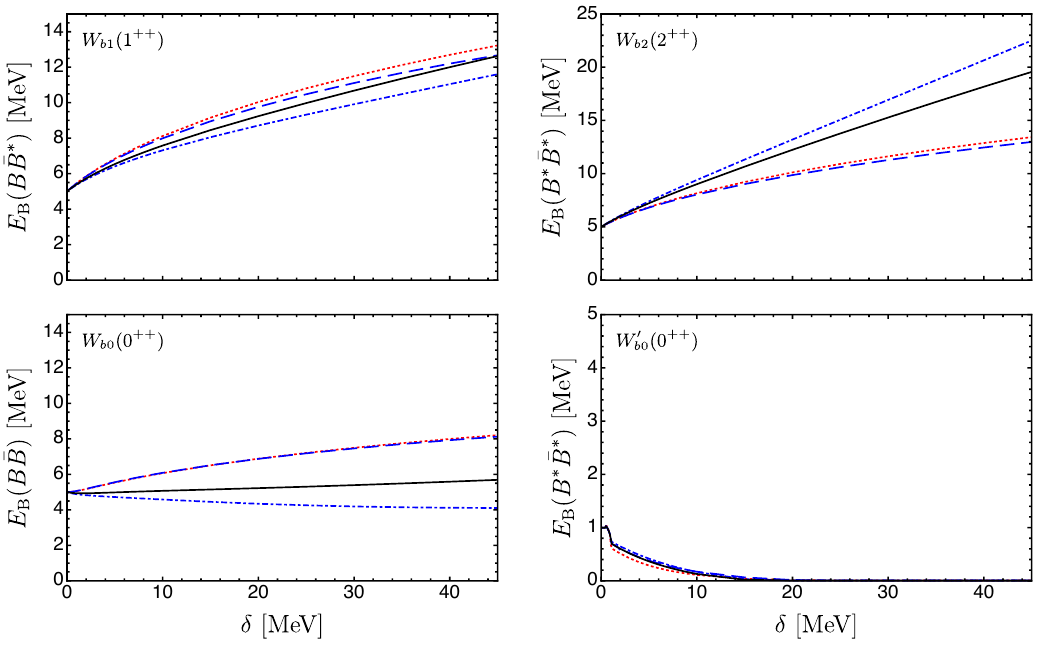
Figure 1 . Evolution of the binding energies of the Z b ’s spin partners calculated with and without (cid:25) - and (cid:17) -meson exchanges as functions of the mass splitting (cid:14) between the B (cid:3) and B mesons. The contact terms are re-(cid:12)tted for each value of (cid:14) to provide the given binding energies of the Z b and Z 0 states used as input | see eq. (4.1). The binding energies of the W bJ states are de(cid:12)ned relative to their reference thresholds quoted in parentheses. The red dotted curves correspond to the pionless (purely contact) theory | Scenario A; the blue dashed curves are obtained for the central ( S -wave) part of the OPE included | Scenario B; the blue dashed-dotted lines represent the results for the full OPE, including tensor forces | Scenario C; the black solid curves show the results of the full calculation with both OPE and OEE included on top of the contact interactions | Scenario D. The physical limit corresponds to the right edge of the plots. The results are obtained with the sharp cuto(cid:11) (cid:3) = 1 GeV in the integral equations (3.12). The uncertainty caused by the residual (cid:3)-dependence of the equations can be estimated using the results presented in table